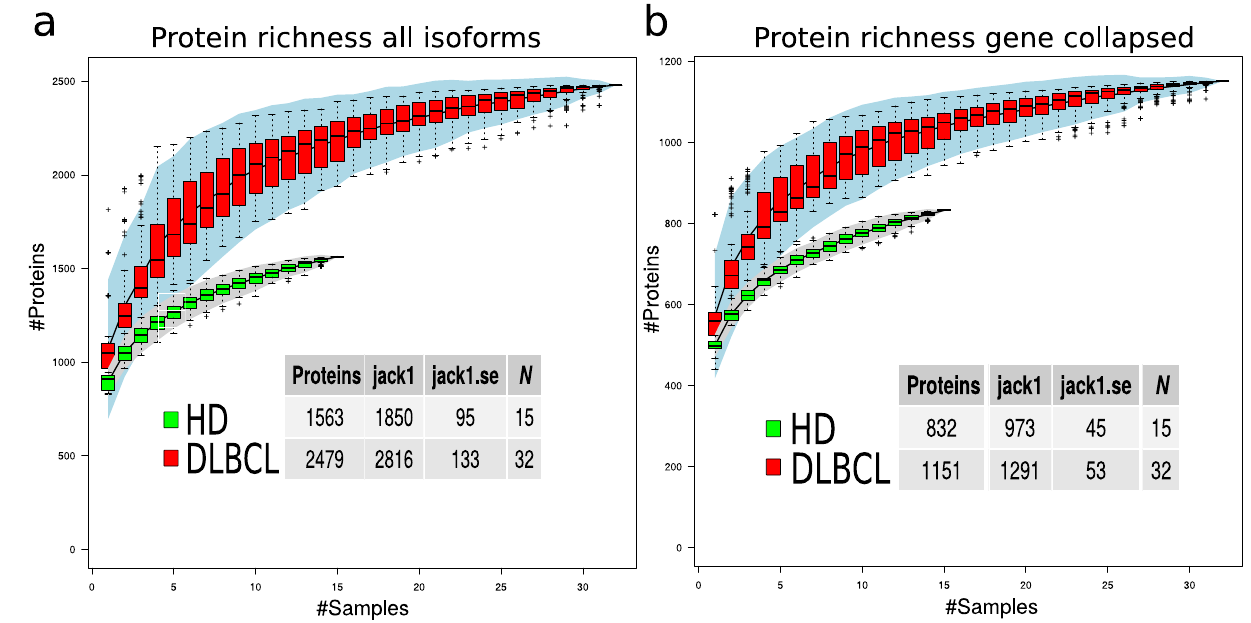
Figure 4. Protein richness in DLBCL and HD groups. ( a ) Protein richness curves for DLBCL (red boxes) and HD group (green boxes) when all protein isoforms are used. ( b ) Protein richness curves for DLBCL (red boxes) and HD group (green boxes) when gene-collapsed proteins were used. The lower tables indicate the estimated number of proteins in the two sample groups using different estimation methods and the corresponding standard error.